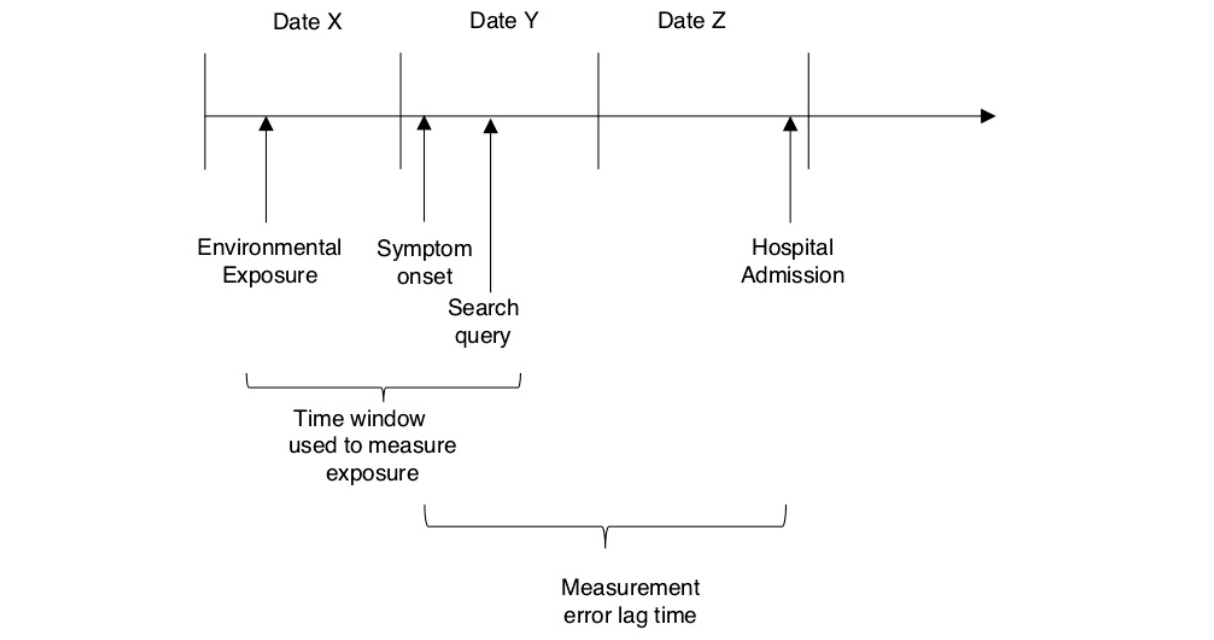
Figure 1. Potential difference in lag time between true time of onset and hospital admission. Diagrammatic representation of exposure measurement error. Date of hospital admission is not necessarily the date of symptom onset and may lead to misclassification, as exposure measurement does not fall within the period of hospital admission. Internet search queries may identify onset of symptoms in real time and earlier than administrative data and reduce measurement